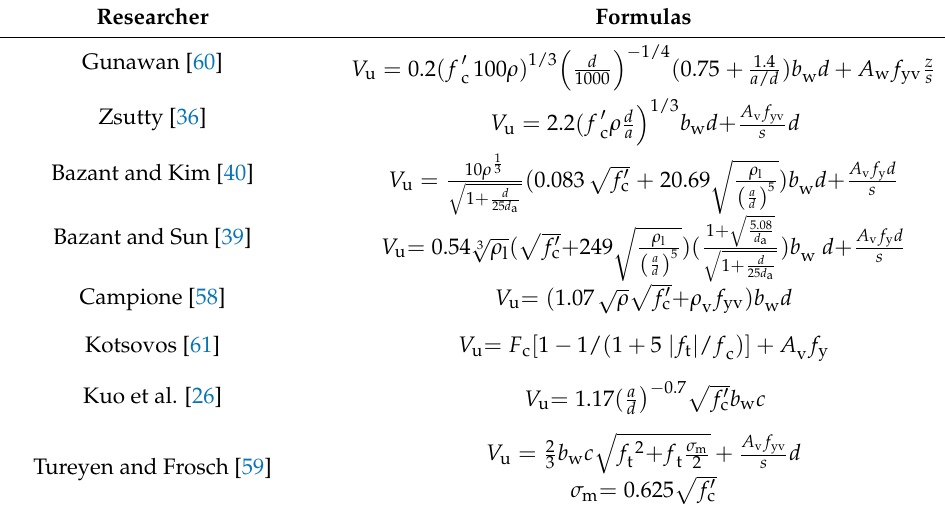
Table A2. Shear strength models proposed by researchers.